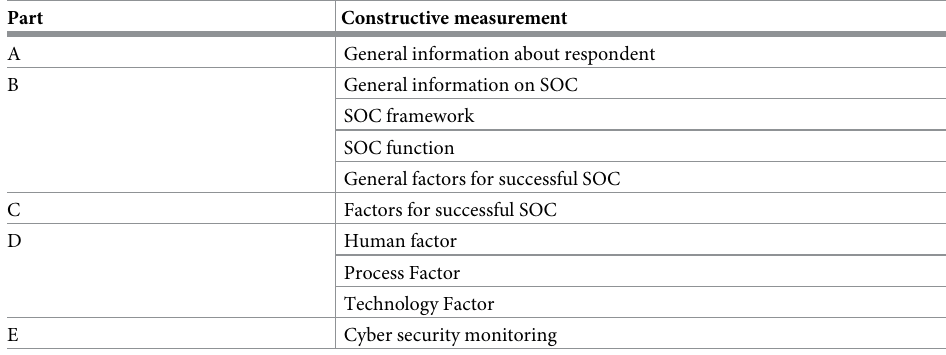
Table 3. Summary of initial instruments for